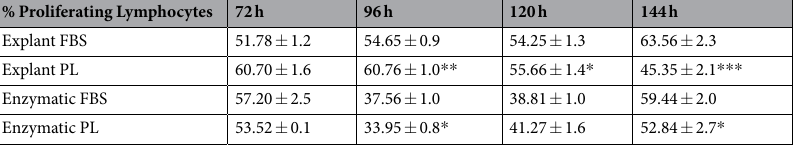
Table 3. Immunosuppressive effect of umbilical cord tissue derived mesenchymal stem cells cultured in FBS and PL supplements on lymphocyte proliferation assessed by MLR assay. Data presented as mean percentage ± SEM of two independent experiments. Statistical comparisons were made within explant and enzymatic groups respectively. * P < 0.05, ** P < 0.01, *** P <